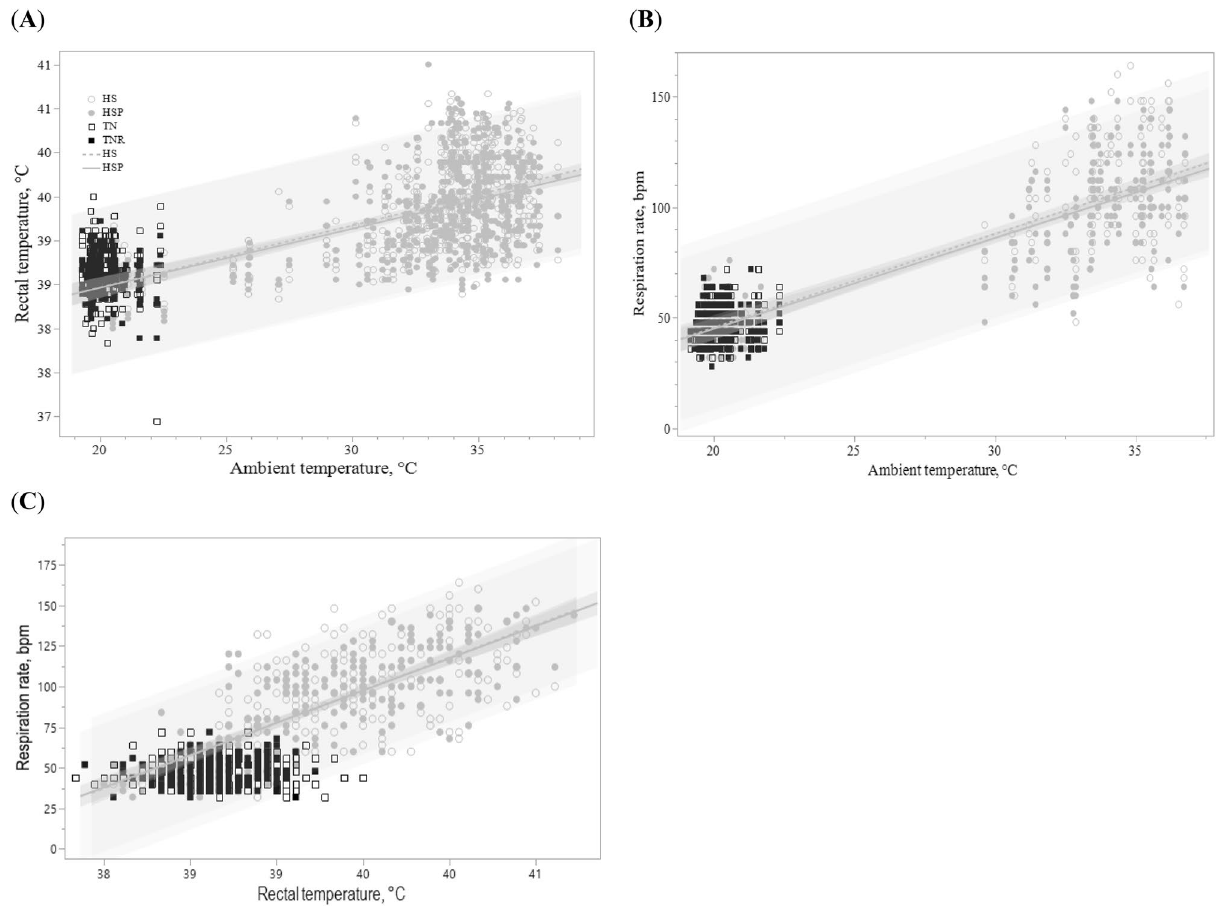
Figure 2. ( A ) Mean rectal temperature and ( B ) respiration rate of Holstein bull calves exposed to thermoneutral (TN), thermoneutral feed-restricted (TNR), heat stress (HS), and heat stress and dietary supplementation with 3 g of AO postbiotic (HSP) plotted against ambient temperature (n = 8 per treatment). Linear relationship is denoted in rectal temperature for HS and HSP, 37.05 + 0.07x (R 2 = 0.30) and 37.12 + 0.06x (R 2 = 0.28), with ambient temperature ( P < 0.0001). ( B ) Linear relationship is shown in respiration rate for HS and HSP, 39.1 − 4.2x (R 2 = 0.59) and 37.1 − 4.1x (R 2 = 0.65), with ambient temperature ( P < 0.0001). ( C ) Linear relationship is shown in respiration rate for HS and HSP, − 1485 + 40x (R 2 = 0.52) and − 1469 + 39.6x (R 2 = 0.59), and rectal temperature (P < 0.0001). Dark gray shaded area shows the 95% mean confidence interval and the (dashed lines) light gray represent the 95% prediction limits. Parameter TN